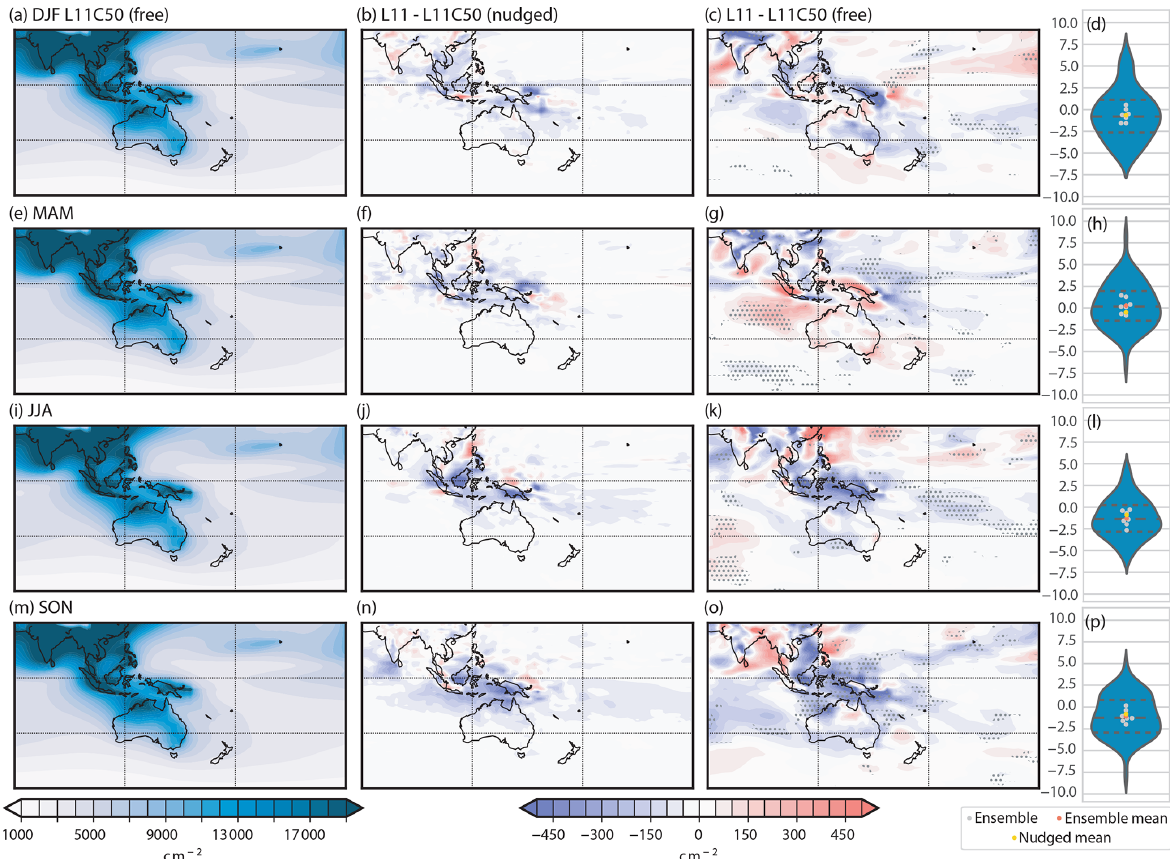
Figure 8. The seasonal (DJF – first row, MAM – second row, JJA – third row and SON – fourth row) total-column CCN 70 concentration (in cm − 2 ) over the broad MC-Aus region for the free L11C50 simulation (first column); the L11–L11C50 difference for the nudged simulations (second column); and the L11–L11C50 difference for the free-running ensemble (third column) with the model agreement shown by stippling, where at least five of the seven ensemble pairs agree in the sign of the difference. The fourth column shows violin plots of the average seasonal difference (L11–L11C50) in total-column CCN 70 over the MC-Aus region as a percentage, where all years in the ensemble are shown by the distribution, the dashed lines represent the 25, 50 and 75th percentiles, the grey dots show the mean of each pair of models, the red dots show the ensemble average and the yellow dots show the nudged